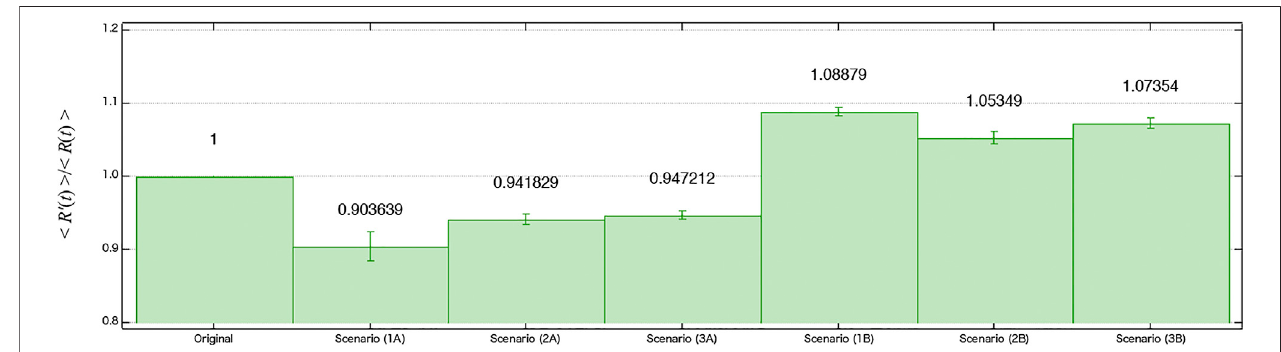
FIGURE 7| Comparison ofhypothetical simulation result of 〈 R ′ ( t ) 〉 , which isthe average ratio between the number of nodes that belong to Group B divided by the number of nodes that belong to Group A, in each scenario, with the result of the original simulation set to unity. Scenario (1A) can reduce the average ratio of Group B most